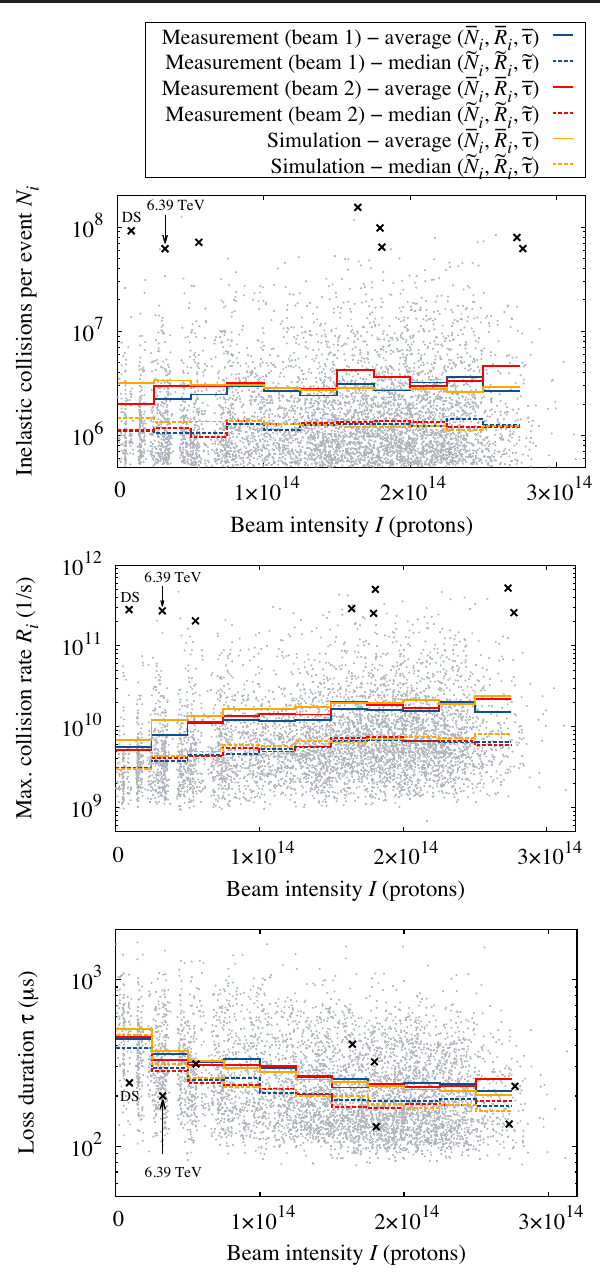
FIG. 11. Number of inelastic proton-nucleus collisions (top), maximum collision rate (center) and loss duration (bottom) of dust particle events as a function of the beam intensity. Every dot represents a loss event reconstructed from BLM measurements in run II. All considered events occurred at 6.5 TeV, except one event at 6.39 TeV. Only events with more than 5 × 10 5 collisions within 640 μ s were considered. The crosses indicate events, which resulted in a magnet quench. The average and median values are indicated by the solid and dashed lines, respectively (beam 1 in blue and beam 2 in red). The yellow lines represent the simulation results (simulation C in Fig.